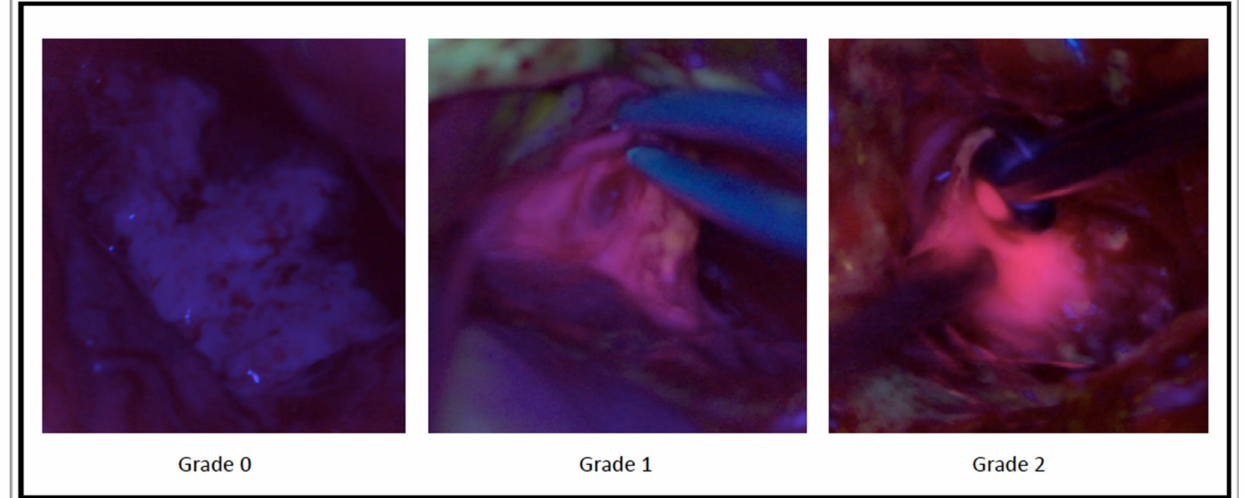
Figure 1. Classification of 5-ALA fluorescence grading scale according to Stummer et al.